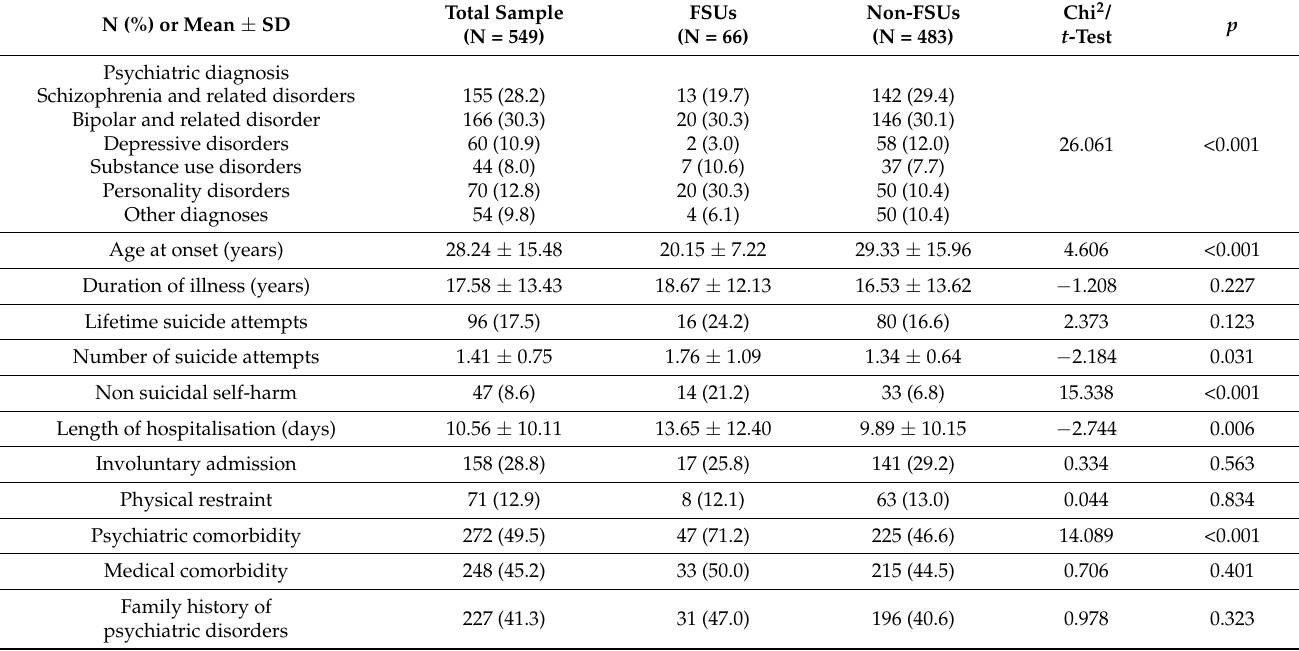
Table 2. Clinical characteristics of the entire sample and of the frequent service users (FSUs) and non-FSUs